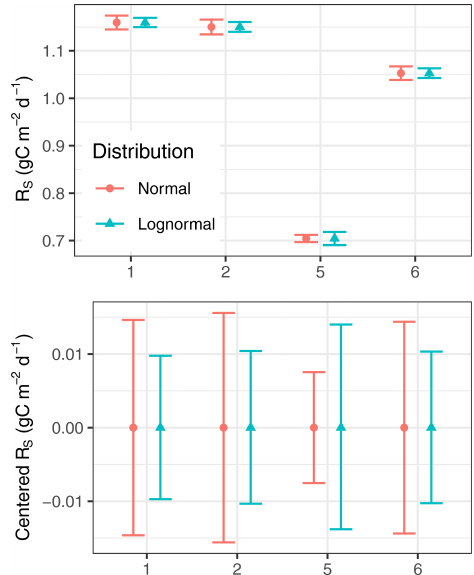
Figure 5. Annually aggregated mean flux estimates (symbols) and their 95% prediction interval bounds (bars) are of similar width for normal and lognormal assumption. The x axis denotes different chamber locations. The aggregation excluded long gaps, which led to different aggregation periods and differences across